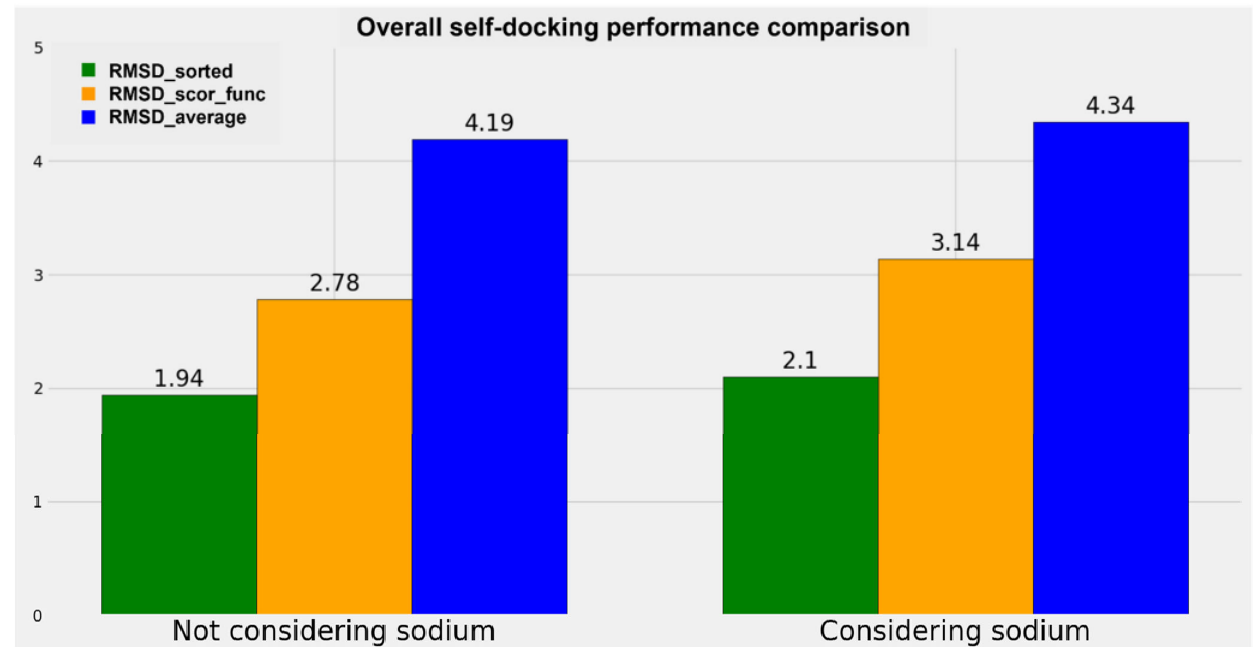
Figure 3. Plot representing the comparison of the overall performance of the different docking algorithms implemented in this study when the sodium ion is not considered during the calculation (on the left ) and when both the sodium ion and the crystal water molecules at 4 Å or nearer to it are included (on the right ). The metrics used for the comparison are the “RMSD_average”, the “RMSD_scor_func”, and the “RMSD_sorted” values already described in the present study.